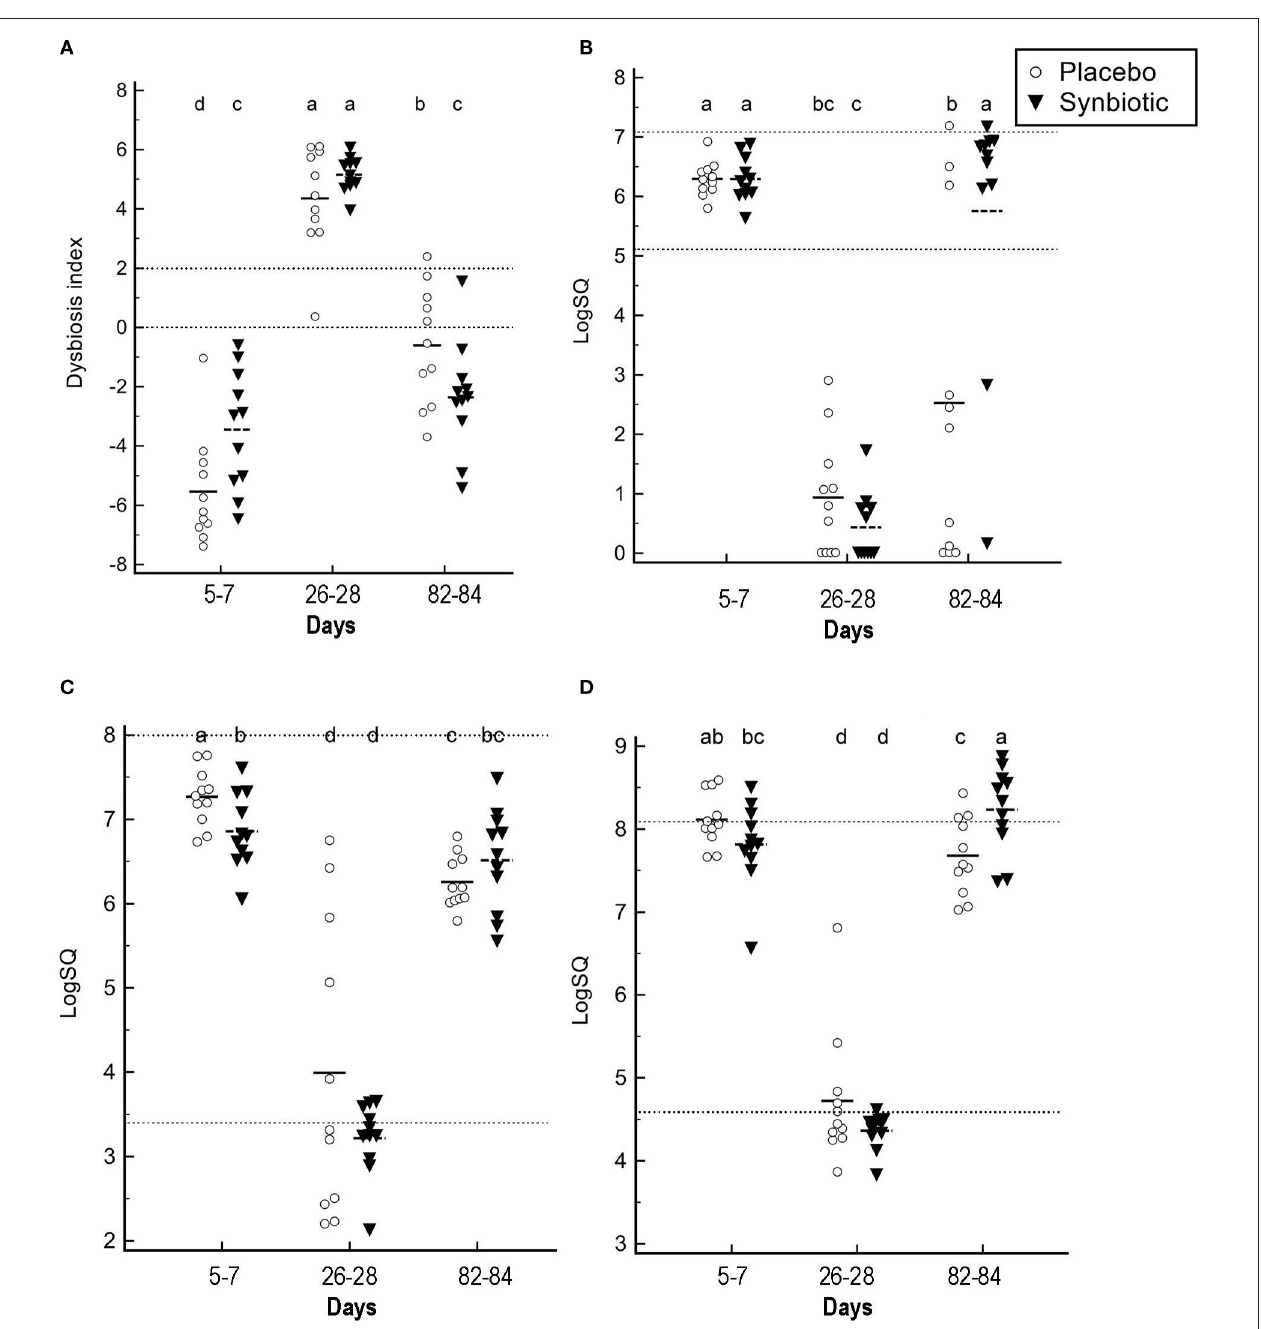
FIGURE 3 | Fecal dysbiosis index results and selected bacterial abundances determined by qPCR. (A) Dysbiosis index. (B) C. hiranonis . (C) Faecalibacterium . (D) Turicibacter . Medians and individual values are presented for dogs in the placebo (open circles) and synbiotic (black triangles) treatment groups. Dotted lines indicate the reference interval. For the dysbiosis index, values < 0 indicate normobiosis, between 0 and 2 are equivocal, and > 2 indicate dysbiosis. Significance was set as P < 0.05. Abundances that do not share a letter differed significantly based on post-hoc analysis.